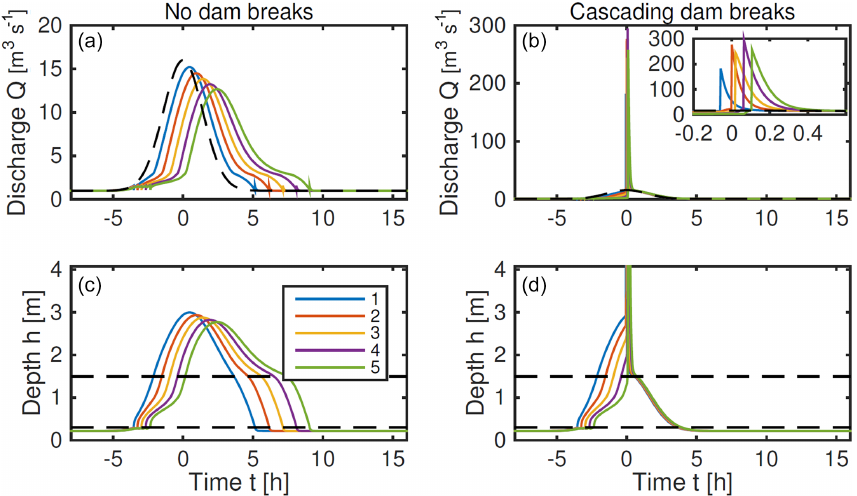
Figure 9. Example from an ensemble of runs on the one-dimensional network in Fig. 2b, forced by the same upstream inflow q(t) = q 0 + q max exp ( − t 2 /σ 2 ) , with q 0 = 1m 3 s − 1 , q max = 15m 3 s − 1 and σ = 2h. The dams have critical failure water depths h c a normal distribution with a mean of 3.5m and standard deviation of 0.5m and shown by the coloured dashed lines in (c, d) . In the case in (a, c) , no dams fail, whereas in the case in (b, d) (when the uppermost dam is particularly weak), they all fail in a cascade. Parameter values are as in Fig.